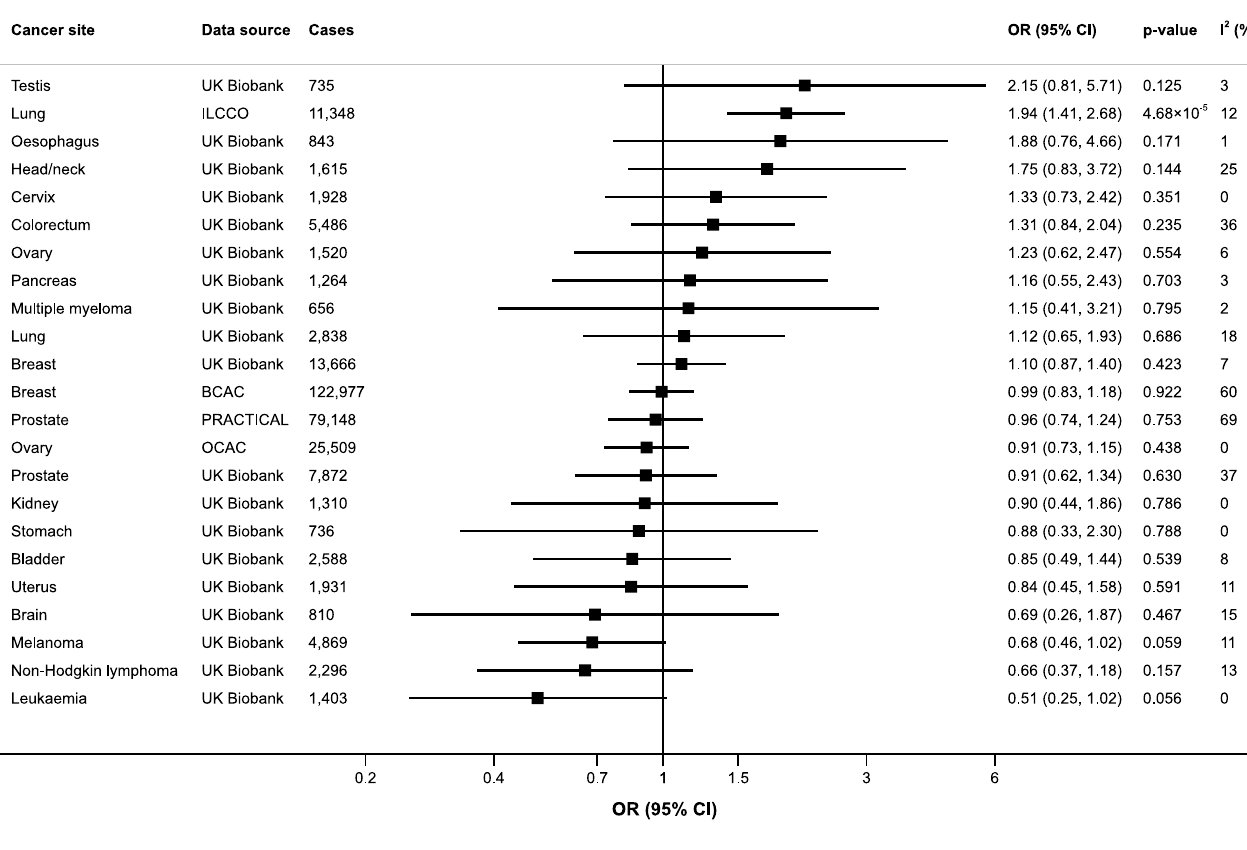
Fig 2. Associations of genetically predicted alcohol consumption with site-specific cancers. ORs are per one standard deviation increase of log-transformed alcoholic drinks per week. Results are obtained from the multiplicative random-effects inverse-variance weighted method. The I 2 statistic quantifies the amount of heterogeneity among estimates based on individual SNPs. BCAC, Breast Cancer Association Consortium; CI, confidence interval; ILCCO, International Lung Cancer Consortium; OCAC, Ovarian Cancer Association Consortium; OR, odds ratio; PRACTICAL, Prostate Cancer Association Group to Investigate Cancer Associated Alterations in the Genome consortium; SNP, single-nucleotide